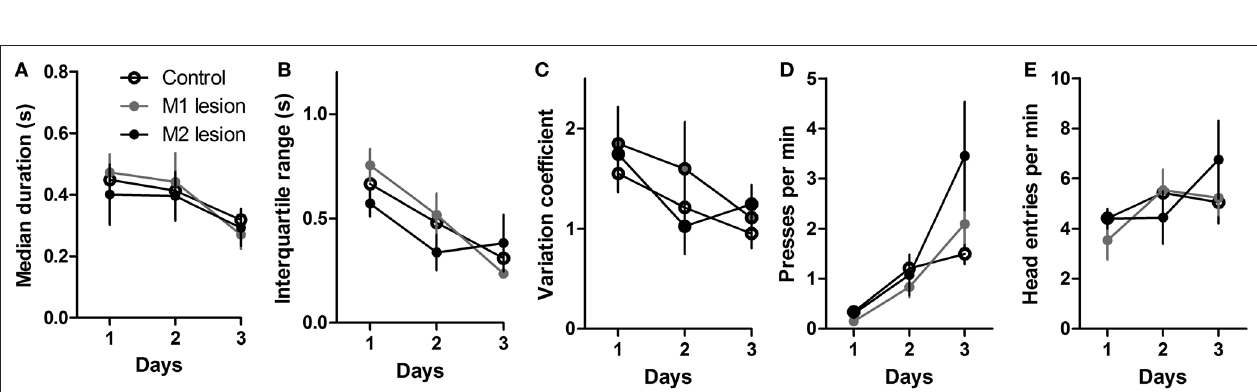
FIgure  | Initial acquisition of lever pressing under continuous reinforcement (CrF, each lever press reinforced with a food pellet). (A) Median duration of the lever press during initial acquisition. (B) Interquartile